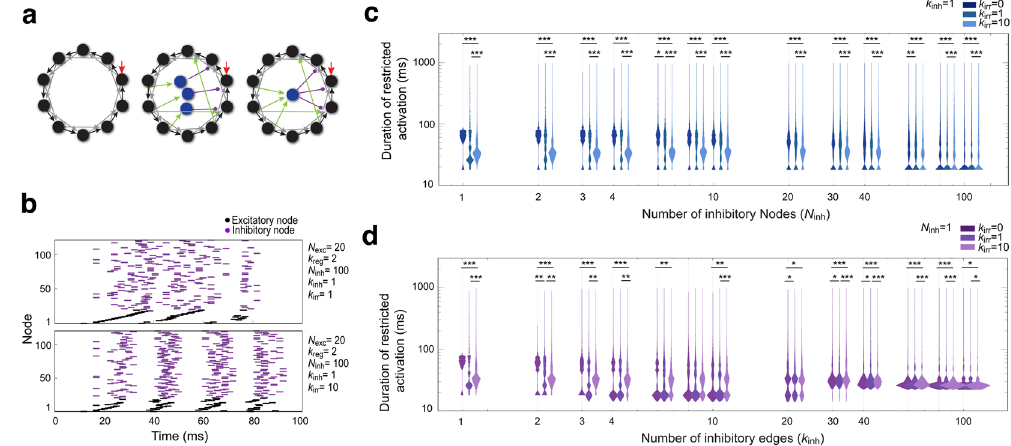
Figure 8. Attaching additional excitatory edges in combination with addition of inhibitory nodes expands the encoding capacity of a network. ( a ) Diagram depicting the random addition of excitatory edges and inhibitory nodes to the basic regular network. Left : the basic regular network structure, in which k irr = 0. Middle : a network structure with two irregular edges (green, k irr = 2), and three additional inhibitory nodes (blue, N inh = 3). The irregular edges originated from existing excitatory nodes in the network and randomly extended to other excitatory nodes. Each added inhibitory node possesses one excitatory supply edge (green) and one inhibitory projection edge (magenta) at k inh = 1. Right : a network structure with two irregular edges (green, k irr = 2) and an additional inhibitory node (blue, N inh = 1) with three excitatory supply edges (green) and three inhibitory projection edges (magenta, k inh = 3). ( b ) The dynamics of network activation are shown as spike raster plots. ( c ) 5000 network structures were constructed by adding irregular edges ( k irr = 0, 1 or 10) to the basic regular network ( N exc = 20 and k reg = 2) with a gradual increase in the number of inhibitory nodes ( N inh various, k inh = 1). The distributions of restricted activation duration at a given number of inhibitory nodes are shown as violin plots. The violin plots are shown such that at a given N inh , the plot of k irr = 0 is aligned over that N inh . ( d ) 5000 network structures were constructed by adding irregular edge ( k irr ) to the basic regular network with one additional inhibitory node that was associated with an increasing number of inhibitory edges ( N exc = 20, N inh = 1, k reg = 2, k inh various). The violin plots at a given k inh are shown such that the plot of k irr = 0 is aligned over that k inh . Statistical significance was assessed with the Mann–Whitney U -test. * p < 0.05, ** p < 0.01, *** p < 0.001 (Table